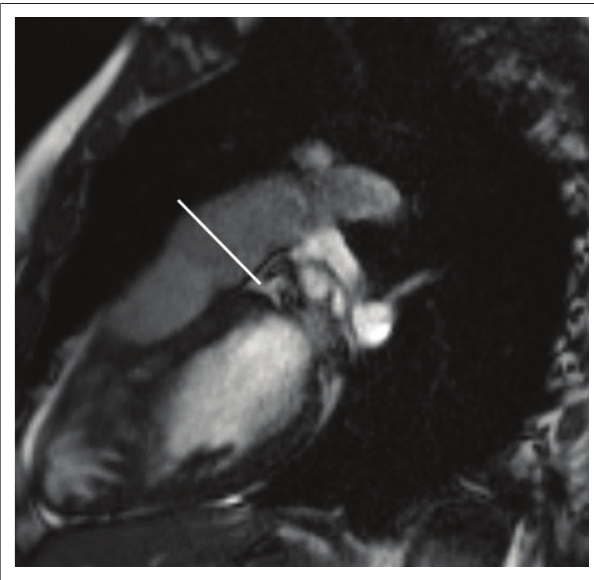
FIGURE 11: Right ventricle outflow tract cine SSFP image. The phase contrast sequence is planned perpendicular to the vessel (white line), in this case the pulmonary artery.